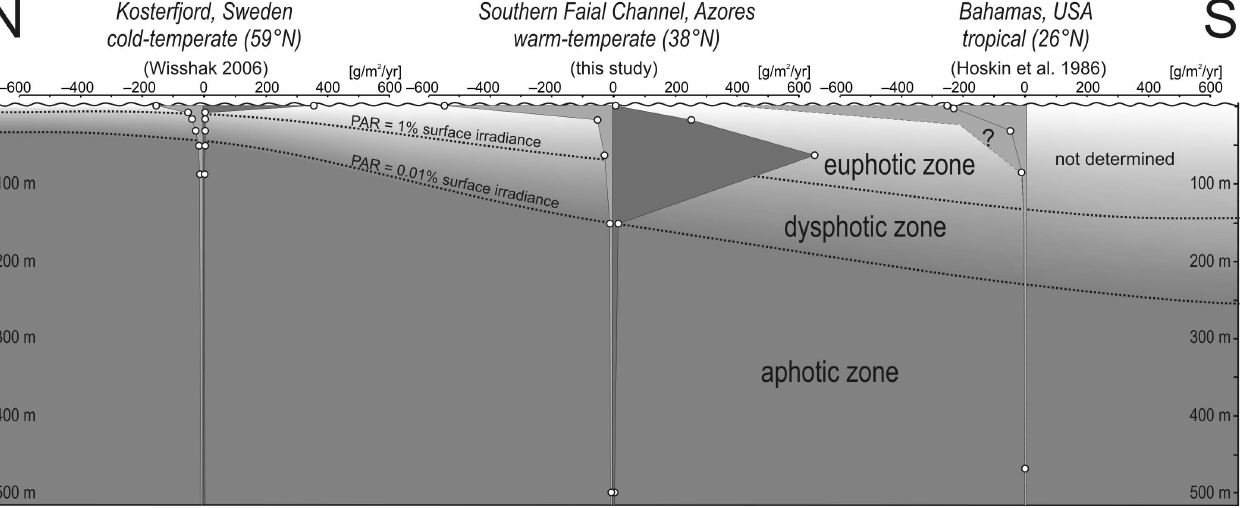
Fig. 7. Carbonate bioerosion and accretion rates along a latitudinal and environmental gradient of the N-Atlantic from the cold-temperate Kosterfjord (data from Wisshak, 2006; up-facing substrates only), to the warm-temperate Azores archipelago, to the tropical Bahamas (data from Hoskin et al., 1986; 3-D substrates). In addition, the vertical extend of the photic zonation is illustrated (data from Wisshak et al., 2005 and Vogel et al., 2000).